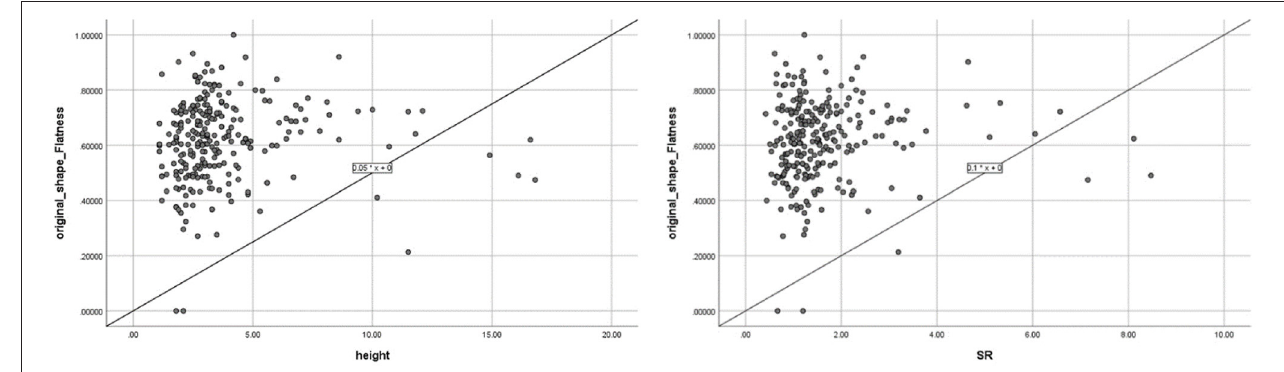
FIGURE 7 | Correlation between Flatness and the two traditional morphological features (height and size ratio, which showed significant correlations with Flatness).